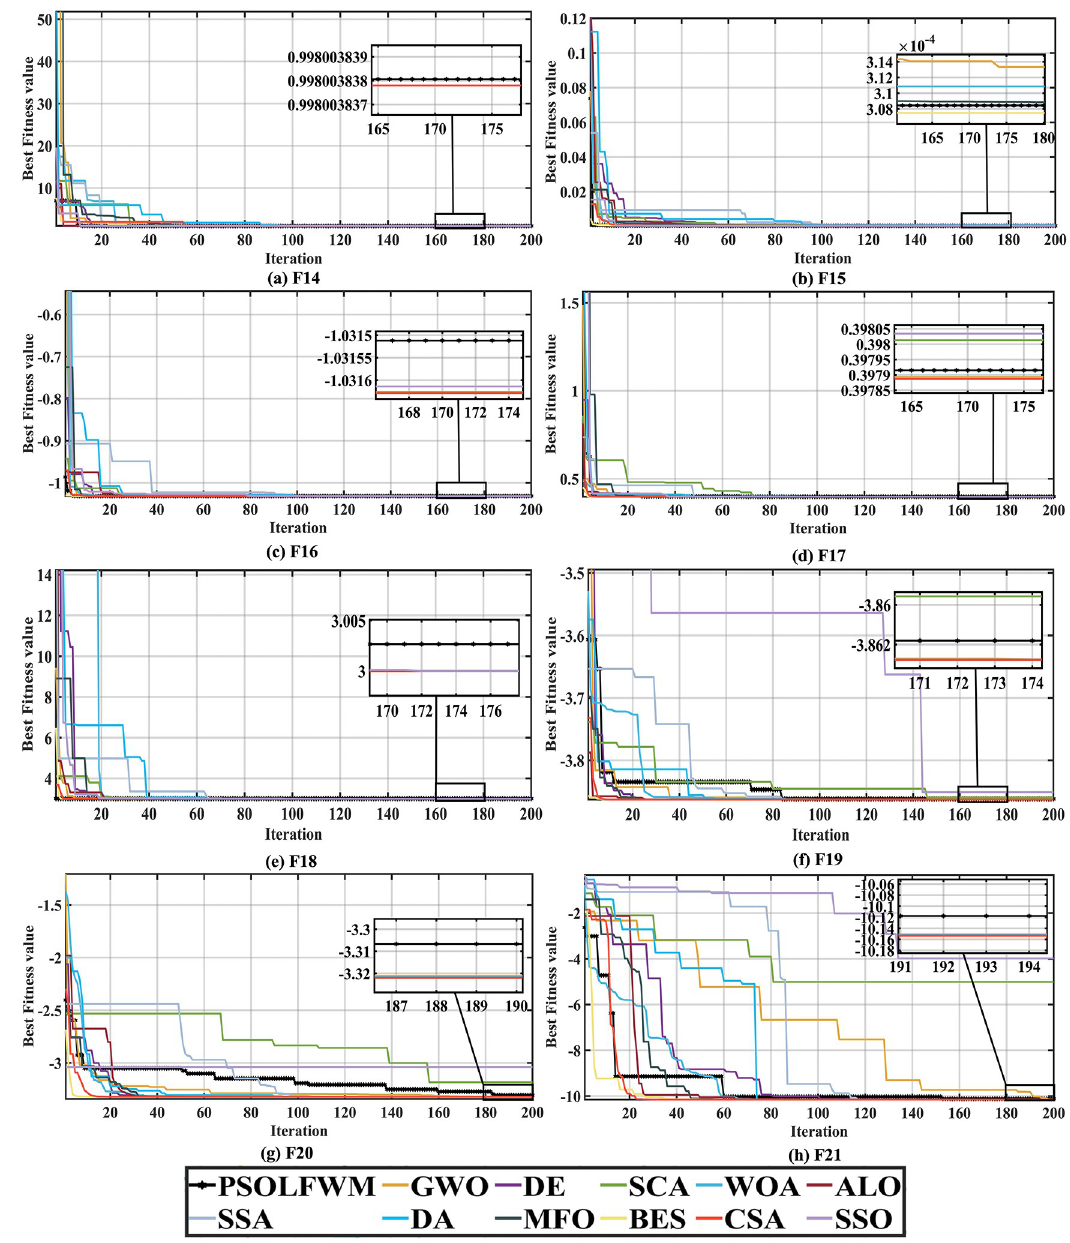
Fig 5. Convergence curve of multimodal functions compared with the meta-heuristic algorithms. (a) F14, (b) F15, (c) F16, (d) F17, (e) F18, (f) F19, (g) F20, and (h) F21.